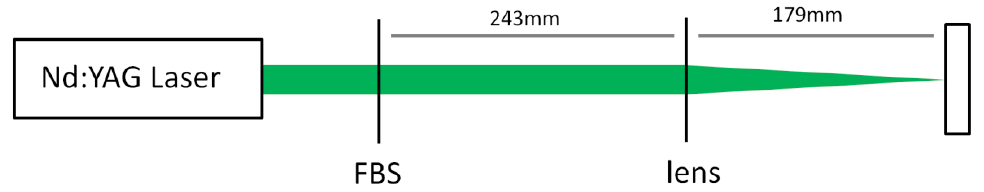
Figure 8. Experimental setup used for characterizing the produced Top-Hat profiles, with a frequency doubled cw Nd:YAG laser (532 nm wavelength, output power ~10 mW).